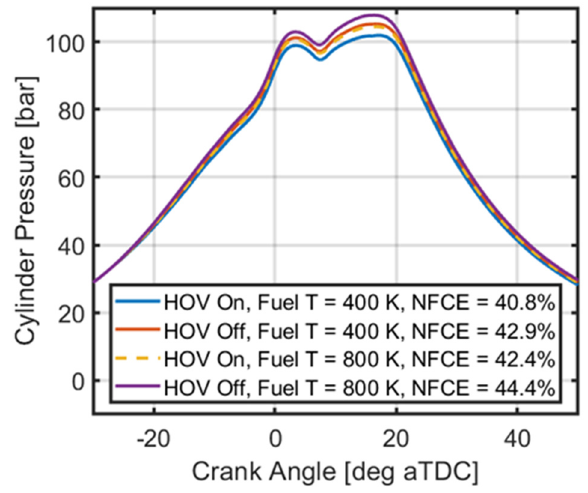
Figure 14. Cylinder pressure vs. crank angle for four simulated mixing-controlled cases. The legend indicates whether the heat of vaporization (HOV) is on or off (“on” meaning that the actual HOV of wet ethanol 80 is used, and “off” meaning that the HOV was artificially set to zero) in the model, the fuel temperature at injection, and the net fuel conversion efficiency (NFCE).